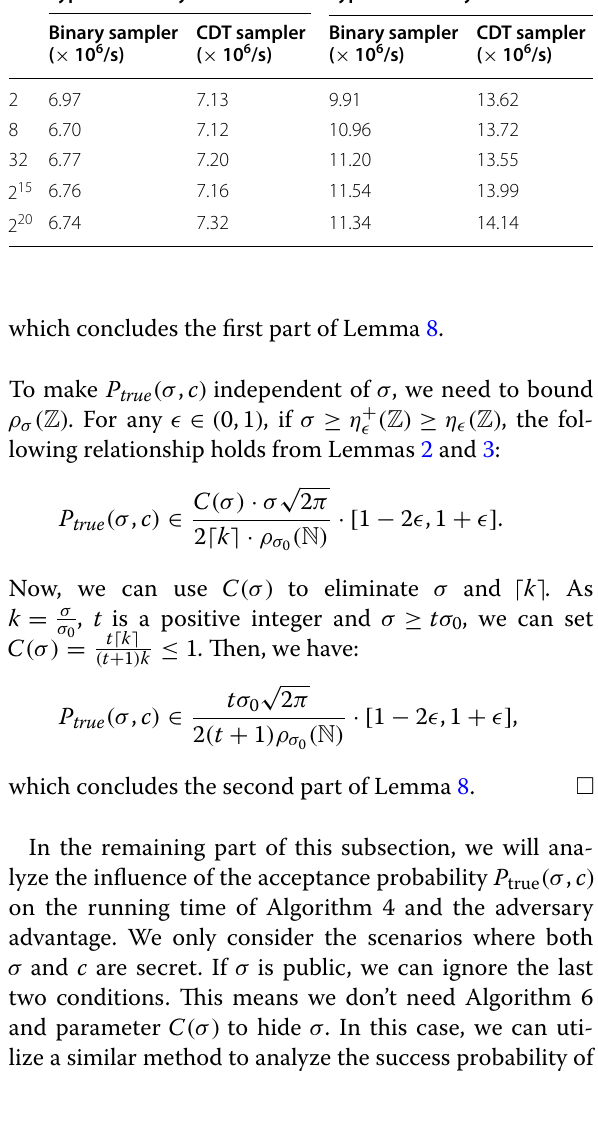
Table 7 Summary of previous works at 3.6 GHz